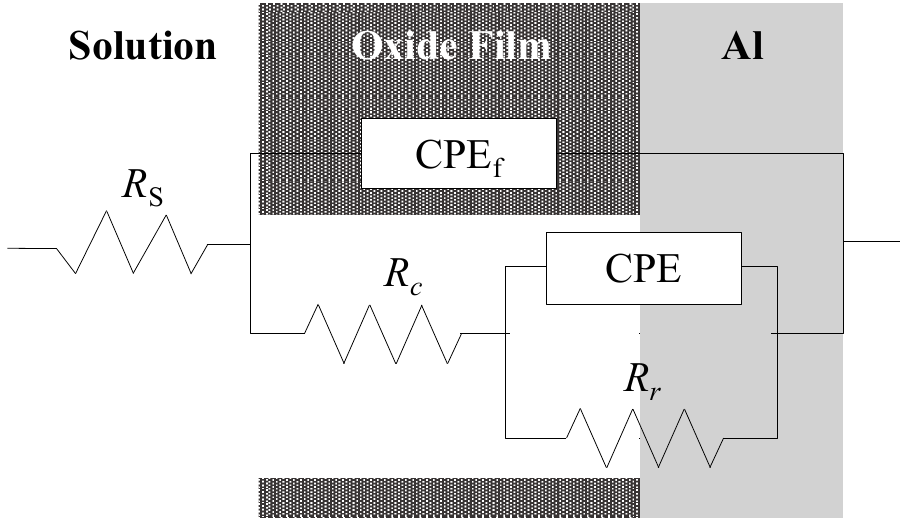
Figure 17. Relationship between solution resistance in cracks, R c , and anodizing time, t a , obtained for pure Al, 1050-Al alloy, 3003-Al alloy and 5052-Al alloy with t p = 1200 s. Anodizing condition is described in Figure 3, and pore sealing condition is described in Figure 9. 5. Conclusions In the present investigation, changes in the structure and corrosion protection ability of porous anodic oxide films on pure Al and Al alloys by pore sealing treatment, were examined, and the following were concluded. (1) Pure Al after anodizing for 1800 and 3600 s has uniform porous oxide films with a smooth surface, but 1050-, 3003- and 5052-Al alloys have porous oxide films with imperfections, including pits and cavities.